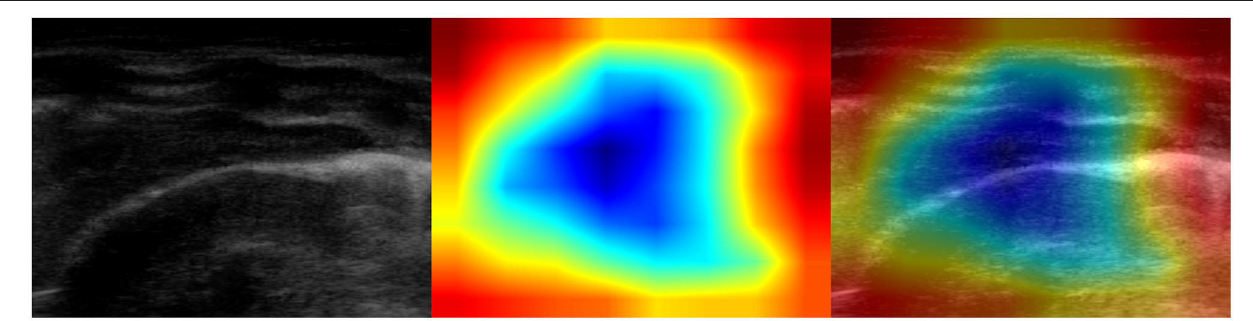
FIGURE 9 | Example of lung ultrasound image of a healthy lung incorrectly classified as bacterial pneumonia by the best performance model (Inception-v3). (Left) Original LUS image; (Middle) Class activation mapping produced by the Grad-CAM visualization; (Right) The class activation mapping overlaid transparently on the original LUS image. Note that red and orange regions corresponds to high scores for the predicted class and highlight what might be confused with consolidations, being the image really dark. This mistake helps us to better understand how the training set should be balanced with a more comprehensive inclusion of the different visual